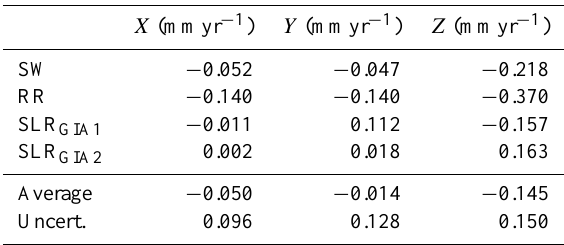
Table 3. Trend for the geocenter motion. The first line (SW) re- ports the trend computed for Swenson et al. (2008). The second line (RR) reports the trend found in Rietbroek et al. (2012b). The third and fourth lines use the trend computed using the SLR time series ( X = − 0 . 131, Y = 0 . 352, Z = − 0 . 637) minus the GIA geo- center motion given in Wu et al. (2012) for ICE5g/IJ05/VM2 ( X = − 0 . 12, Y = 0 . 24, Z = − 0 . 48), and minus the Klemann and Mar- tinec (2009) GIA contribution ( X = − 0 . 13, Y = 0 . 33, Z = − 0 . 80),